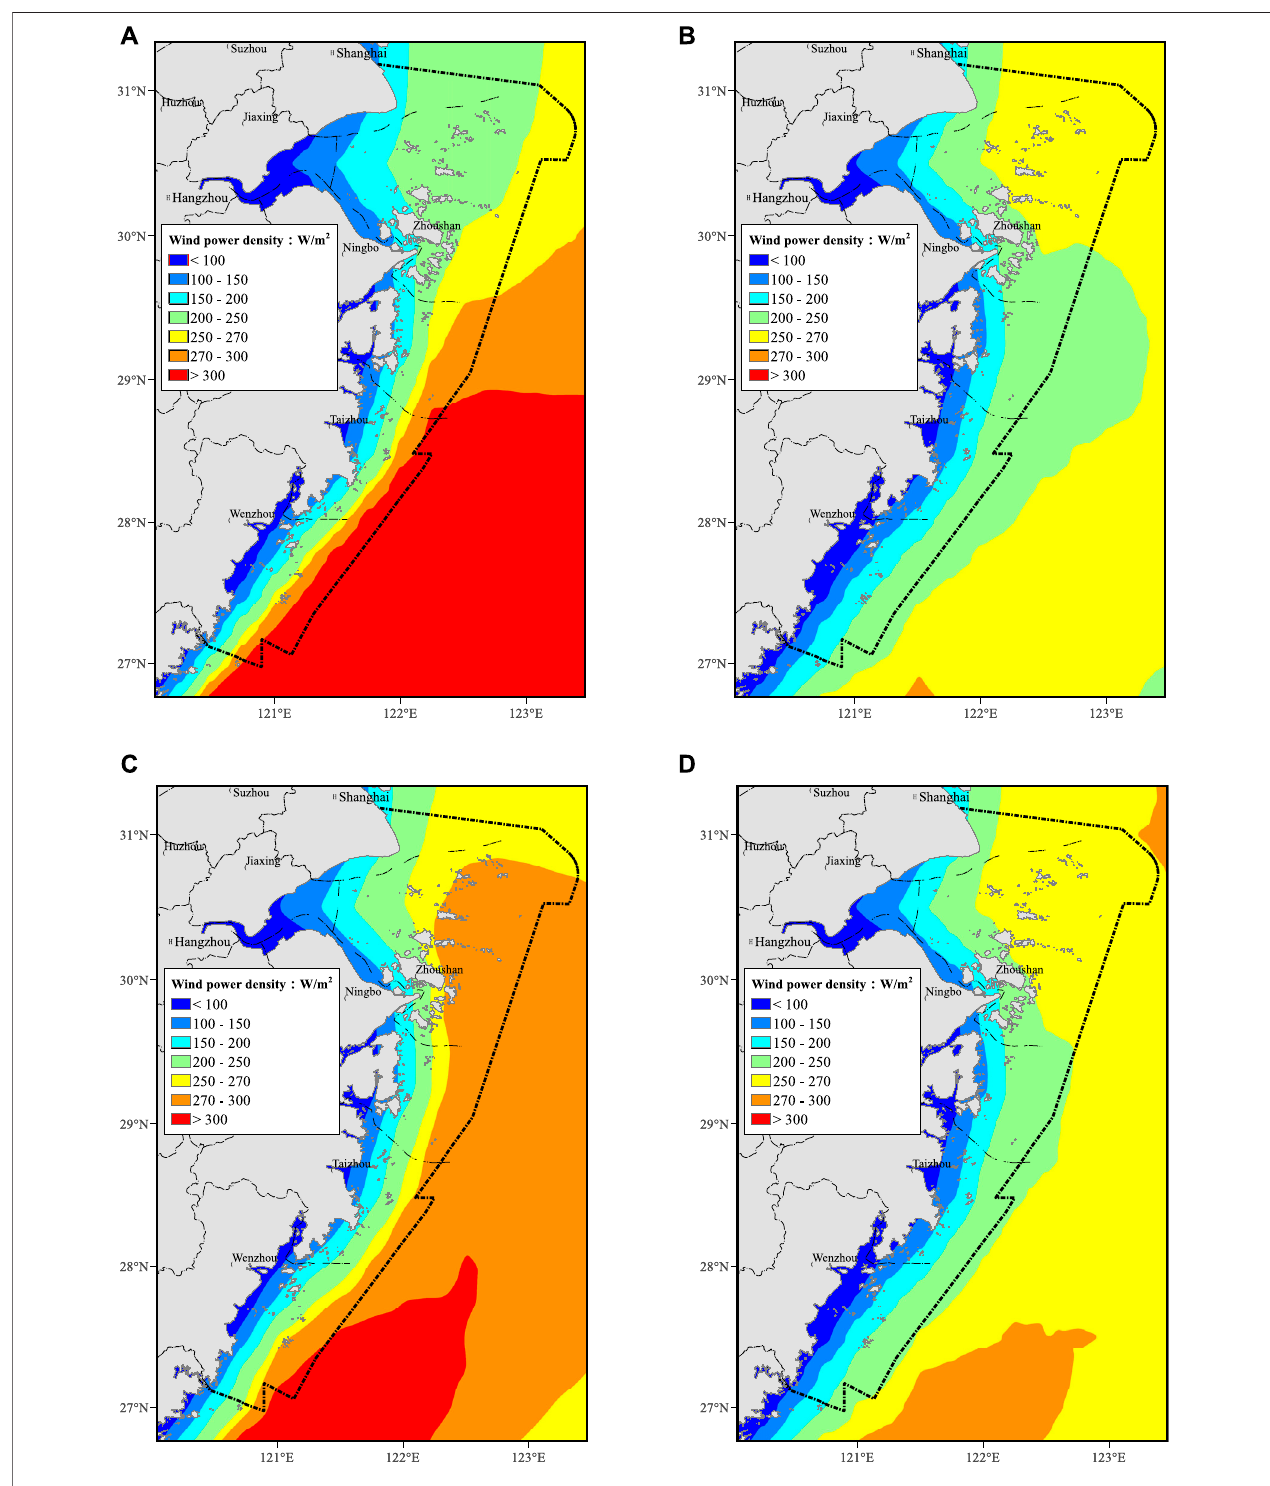
FIGURE3| Spatialdistributionoftheseasonalbehaviorofthemeanwindpower density fortheperiod 1986 – 2015.Theselectedseasons are: (A) winter(DJF); (B) spring (MAM); (C) summer (JJA); and (D) autumn (SON).